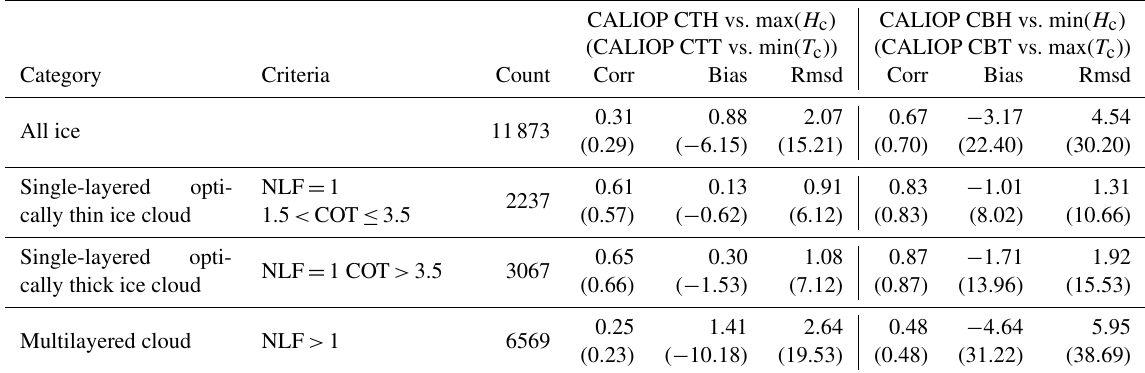
Table 4. Comparison of max( H c ) (min( H c )) to the CALIOP CTH (CALIOP CBH) for all cloud pixels and three cloud regimes; single-layered optically thin ice cloud, optically thick ice cloud, and multilayered cloud for August 2015. Pixel numbers (count), correlation coefficients (corr) and differences of the mean values (bias), and root-mean-square differences (rmsd) are provided. Additionally, comparison of min– max( T c ) to the CALIOP CTT–CBT is also shown as numbers in round brackets.